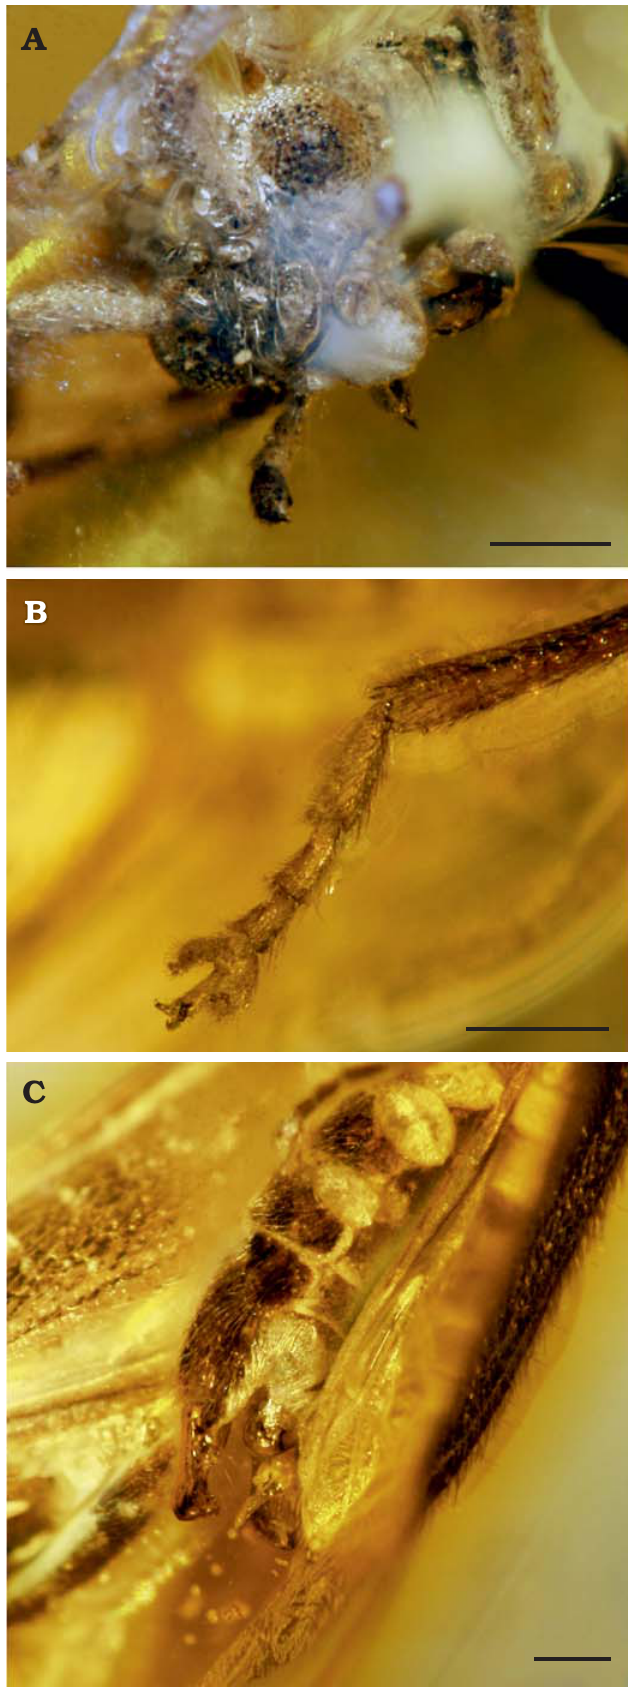
Fig. 2. Soldier beetle Kuskaella macroptera gen. et sp. nov., holotype (UCP UwB 222a), in Baltic amber, middle Eocene to late Eocene; Po- land, Gda ń sk region. A . Detail of palps (ventral view). B . Detail of claws. C . Detail of the visible part of aedeagus. Scale bars 200 μ